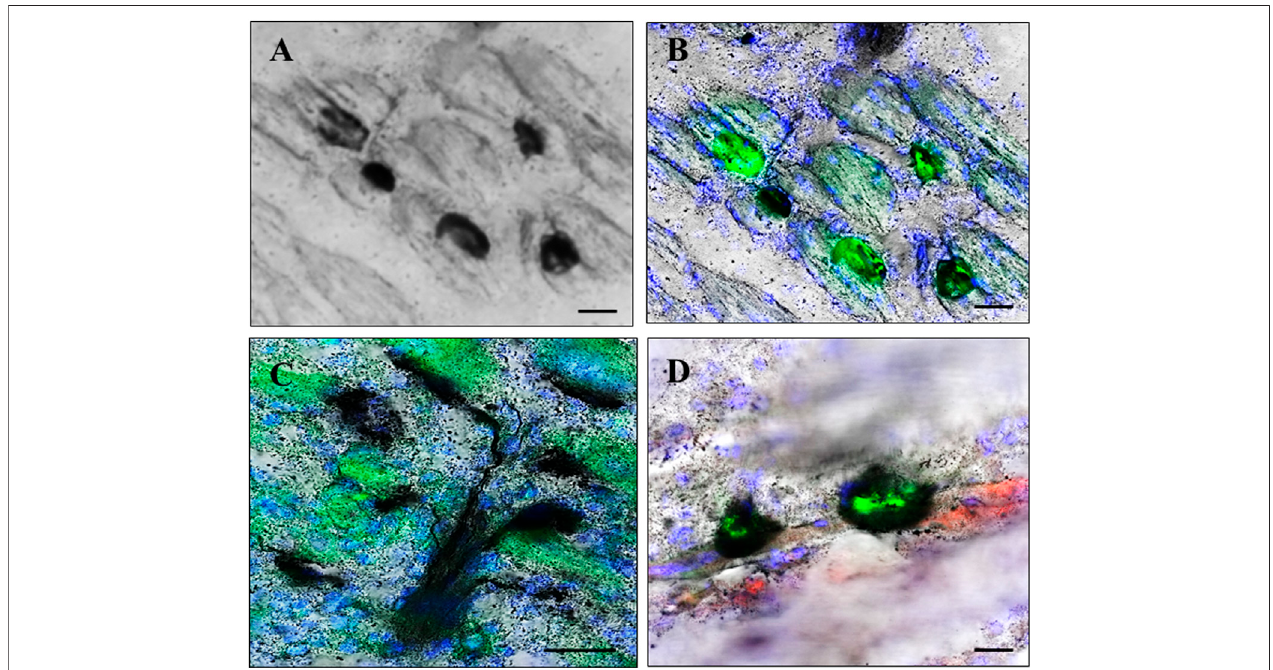
FIGURE 1 | Neuromuscular junction (NMJ) regions. NMJ regions were localized in muscle using a combination of silver staining, enzyme histochemistry, direct fl uorescence, and immunostaining. Presynaptic regions were identi fi ed using silver staining histochemistry for acetylcholinesterase (AchE) enzyme activity and neurites (A) alone,andadditionallylocalizedincombinationwithstainingforpostsynapticacetylcholinereceptor(AchR)plaqueswhichwereidenti fi edbygreen fl uorescenceafter staining with FITC-conjugated α -bungarotoxin (B – D) . Terminal Schwann cells (TSCs) localized in some sections by further immunostaining for S100B protein, identi fi ed by red fl uorescence (D) . (A,B) , and (D) illustrate NMJ regions in regenerating muscle on day 6 after cardiotoxin injury (A,B) and day 8 after muscle-crush injury (D) . (C) Illustrates presynaptic neurites branching toward regions of AchE activity closely juxtaposed to postsynaptic AchR plaques in control muscle without injury. Nuclei are counterstained blue by 4 ′ ,6-diamidino-2-phenylindole (A,C,D) . Bars indicate ×10 µm.